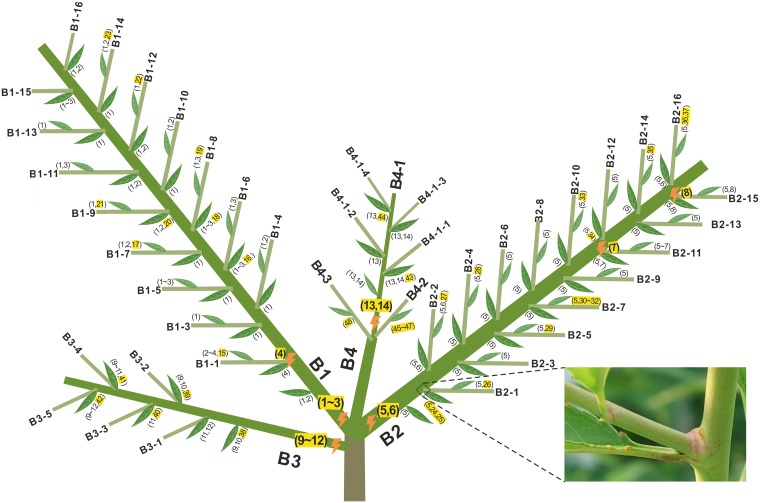
Somatic mutations in a 2-year-old peach tree DHQ1.This tree was from a seed germinated after gibberellin treatment from May to June 2015 and grown outdoor on the campus. The leaves were sampled from the sapling on July 24, 2016. Seventy-five sequenced leaf samples include 43 leaves from the base branch (shown in rectangle), and the others are from small branches.